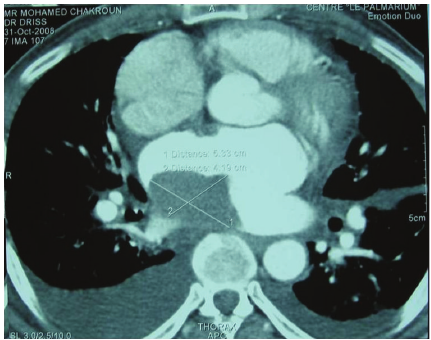
Figure 3: The transthoracic tomography showing a left atrium tissular mass in the left